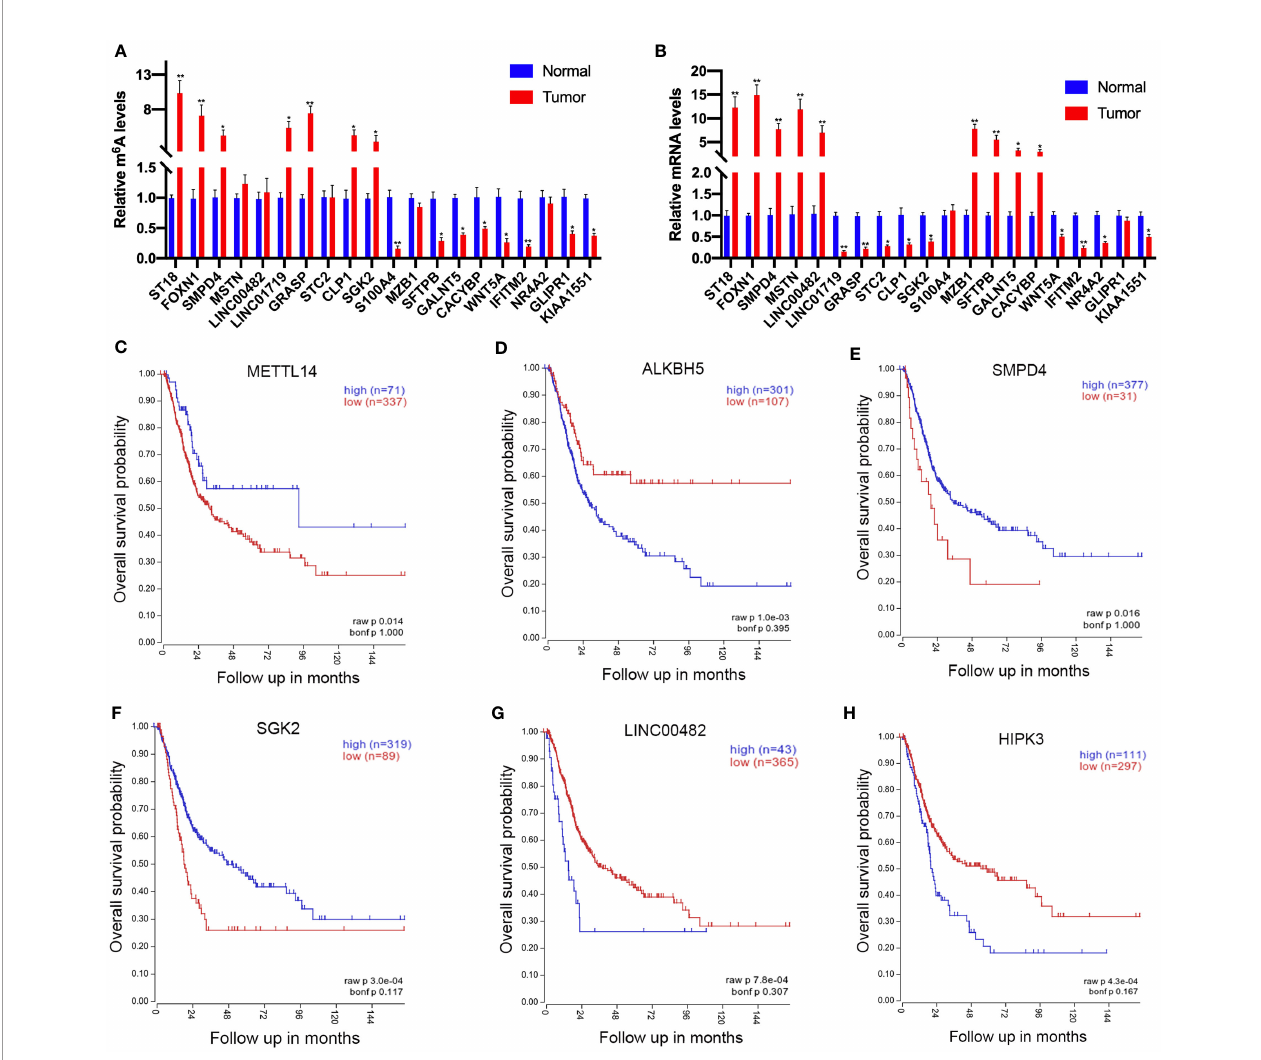
FIGURE 6 | Prognostic value of the survival-associated gene signature in bladder cancer patients. (A) Validations of the m 6 A enrichments of 10 hypermethylated genes and 10 hypomethylated genes by m 6 A-immunoprecipitation (IP)-qPCR. (B) Validations of the mRNA expression levels of 10 upregulated genes and 10 downregulated genes by RT-qPCR. (C – H) The low expressions of METTL14 (C) , SMPD4 (E) , and SGK2 (F) in mRNA level correlate with worse overall survival in bladder cancer patients. The high expression of ALKBH5 (D) , LINC00482 (G) , and HIPK (H) expression levels showed a tendency to correlate with worse overall survival in bladder cancer patients. *p < 0.05, **p <